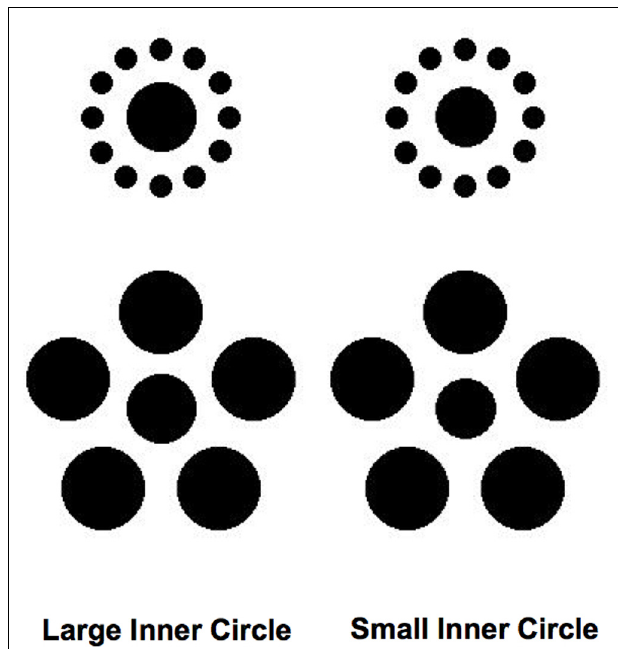
FIGURE 9 | Hypothetical stimuli that could be used in an experiment that would involve having observers discriminate between the sizes of the inner circles rather than detecting their presence (see text for